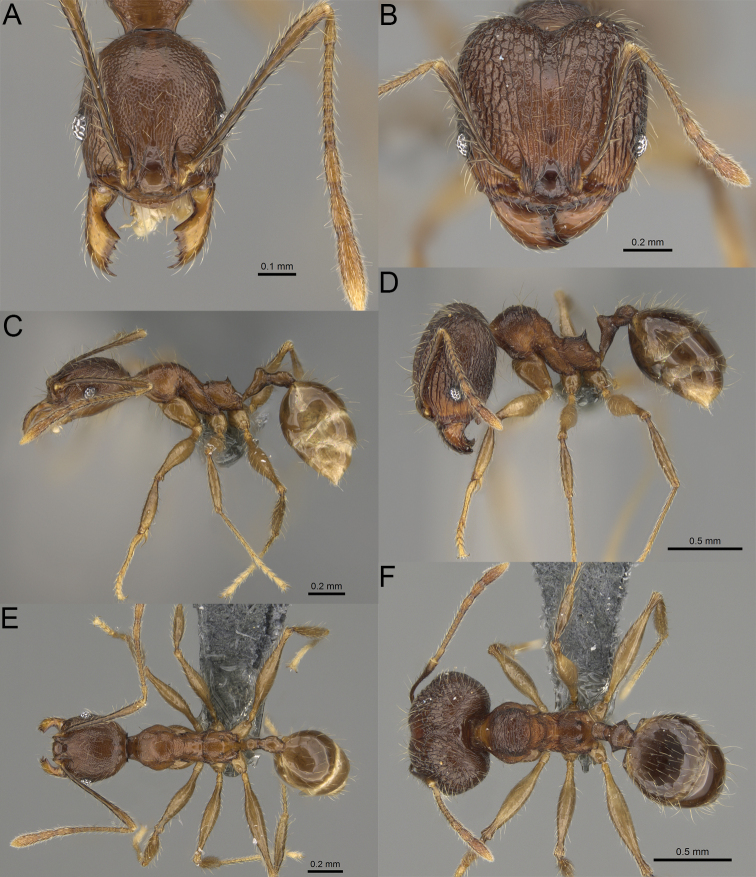
Pheidole
mivory sp. nov., full-face view (A), profile (C), and dorsal view (E) of paratype minor worker (CASENT0923288) and full-face view (B), profile (D), and dorsal view (F) of holotype major worker (CASENT0825256).